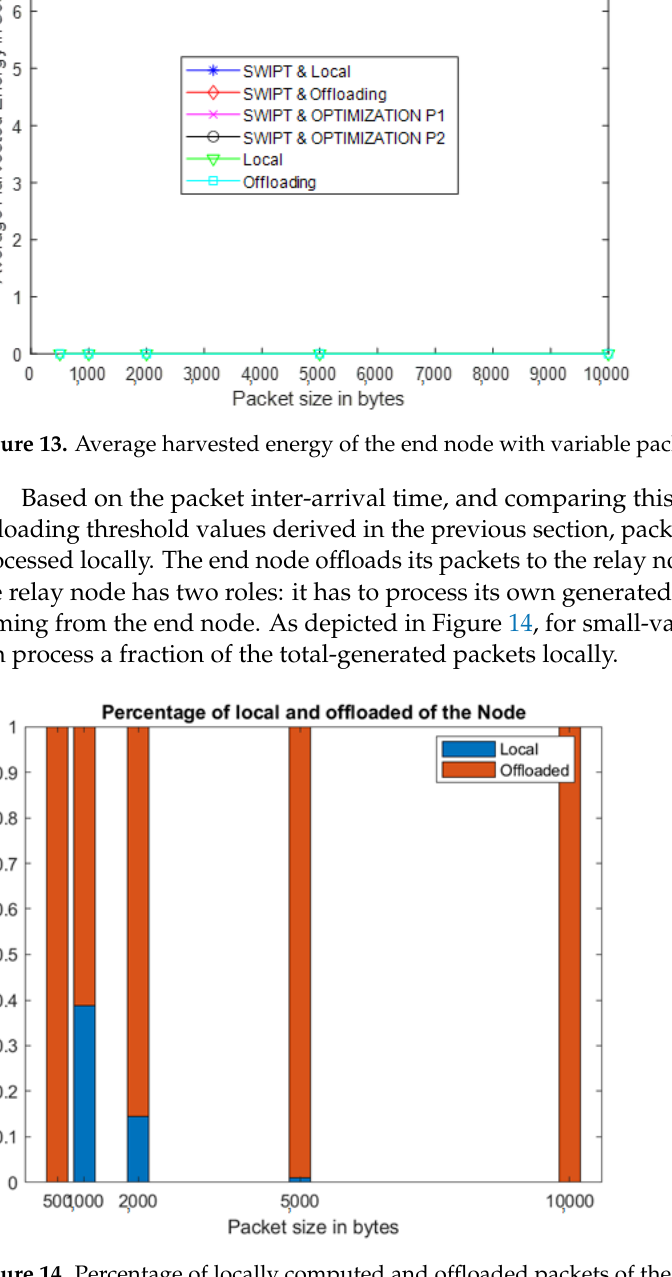
Figure 14. Percentage of locally computed and offloaded packets of the end